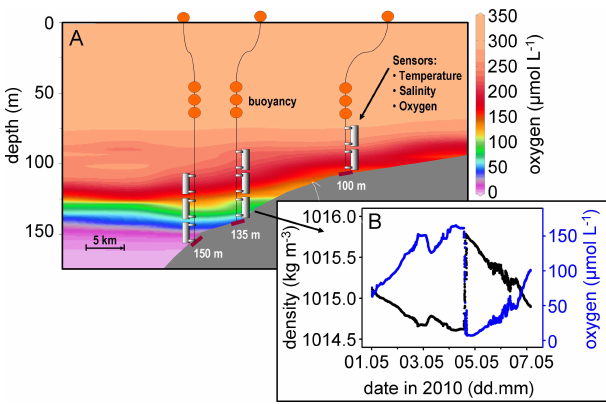
Fig. 4. ( A ) Three moorings were deployed at the southwestern Crimean shelf (Black Sea) from 1 to 7 May 2010 at 100, 135 and 150m depth, measuring temperature, salinity and oxygen concen- tration. The average distribution of oxygen is compiled from 16 CTD profiles taken between 24 April and 7 May. ( B ) Time series of density and oxygen from the lowermost CTD at 135m depth. Oxy- gen correlates with density, showing a gradual increase in oxygen over several days followed by a sudden drop in oxygen concentra- tion of more than 150µmolL − 1 within two